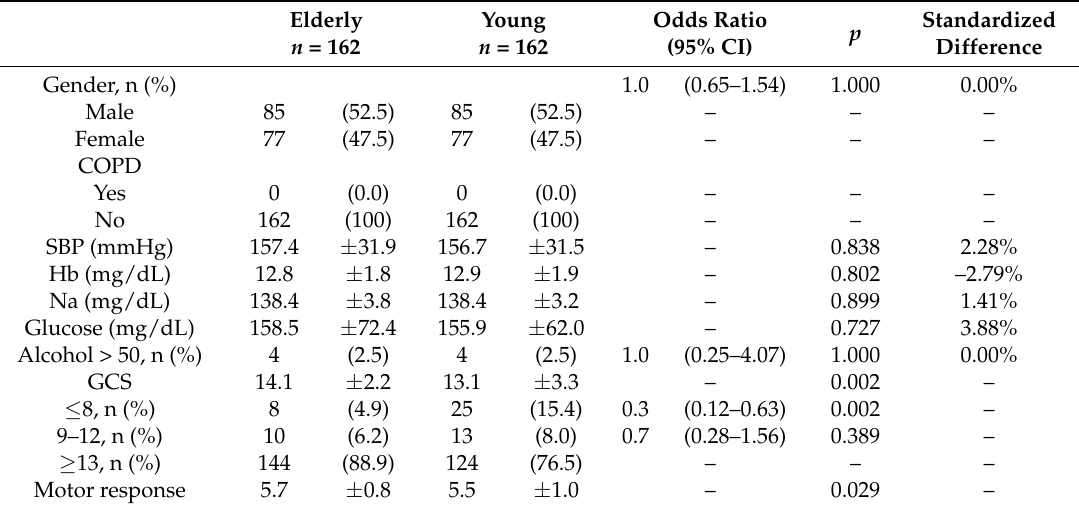
Table 4. Comparison of GCS score and motor response components in the selected propensity–score matched cohort of elderly and young adult patients with head AIS of 3.